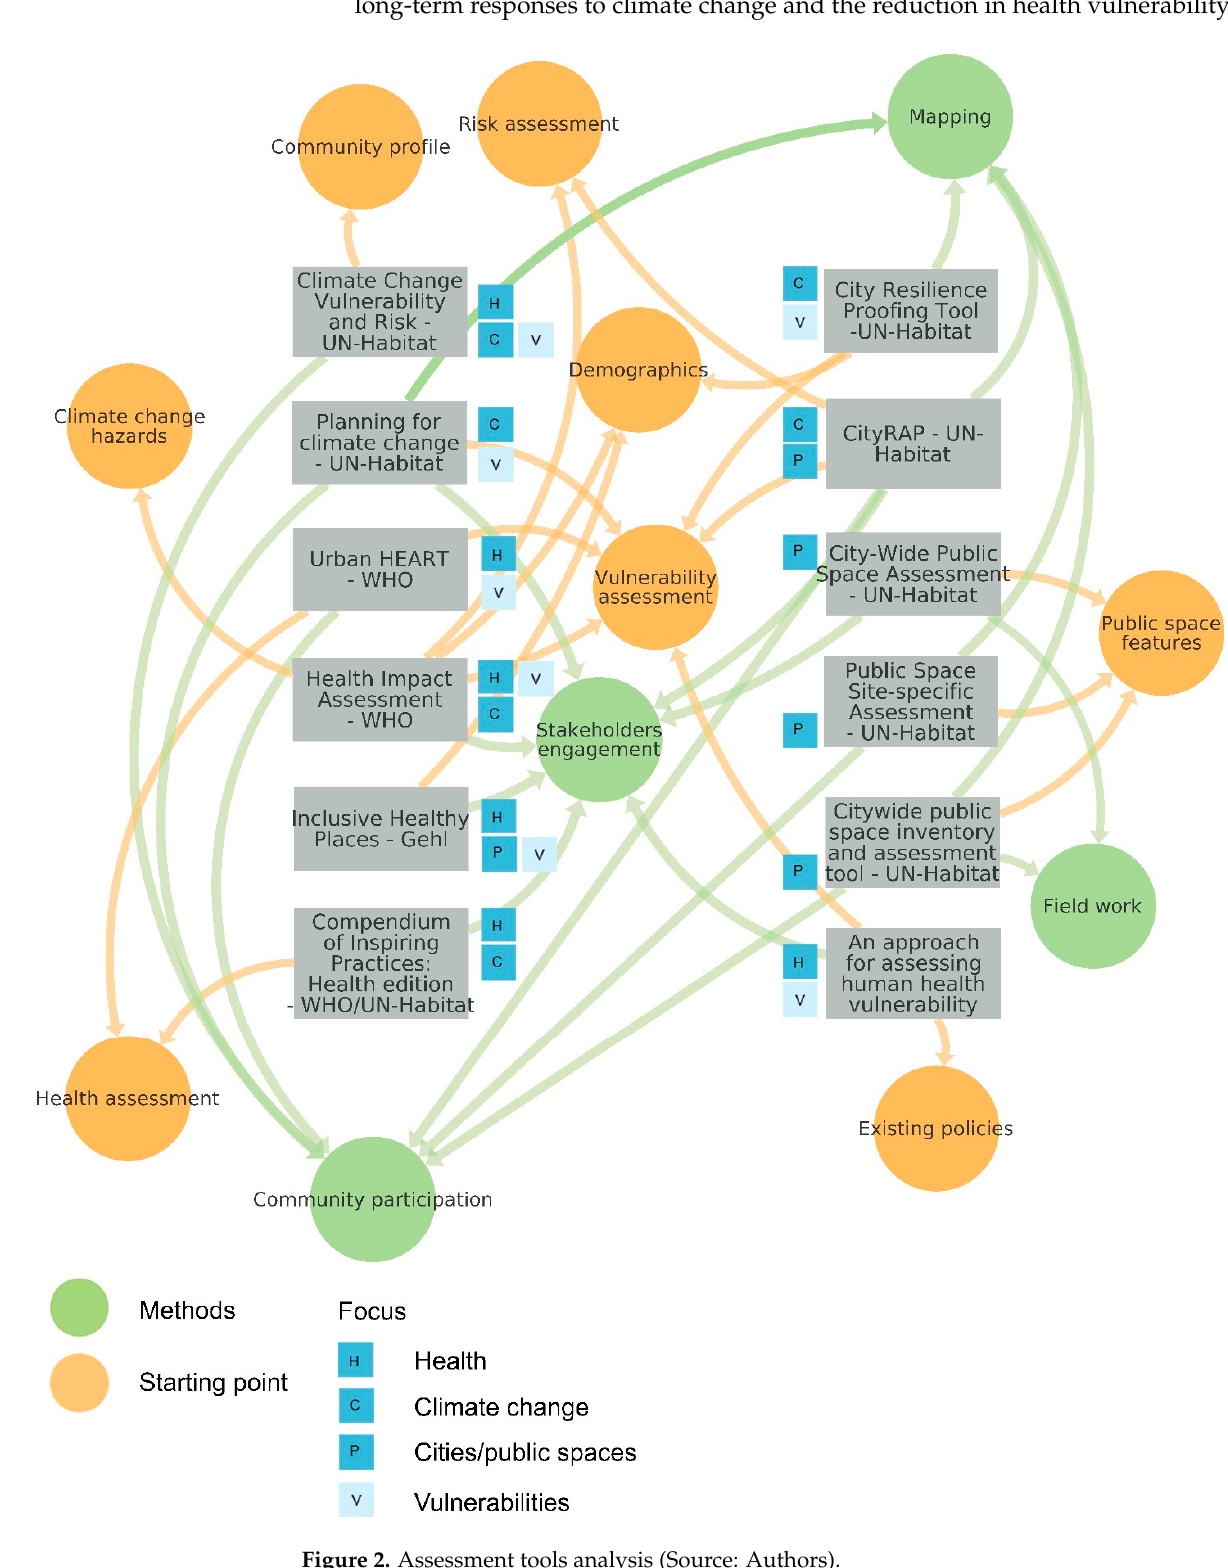
Figure 2. Assessment tools analysis (Source: Authors).